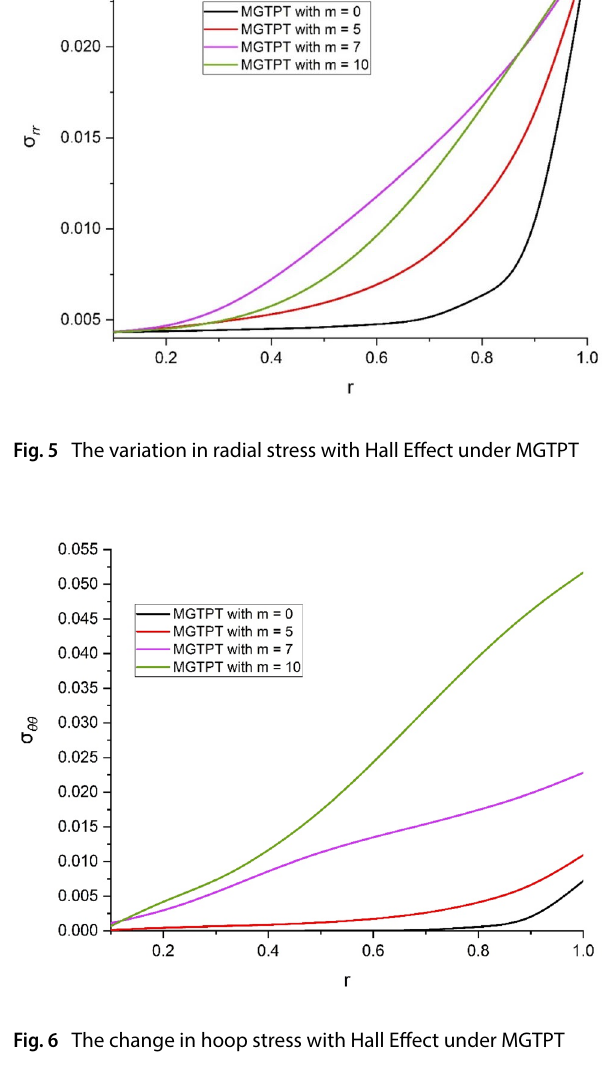
Fig. 4 The change in carrier density with Hall Effect under MGTPT